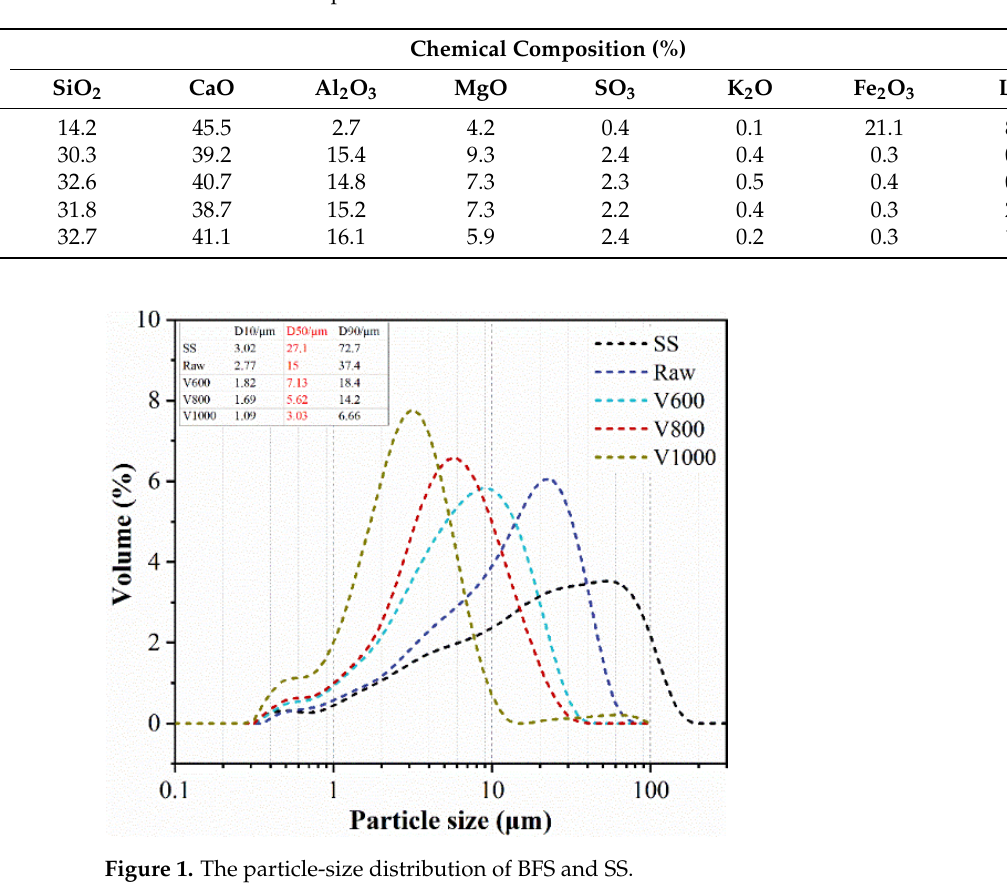
Table 1. Chemical composition of SS and BFS.